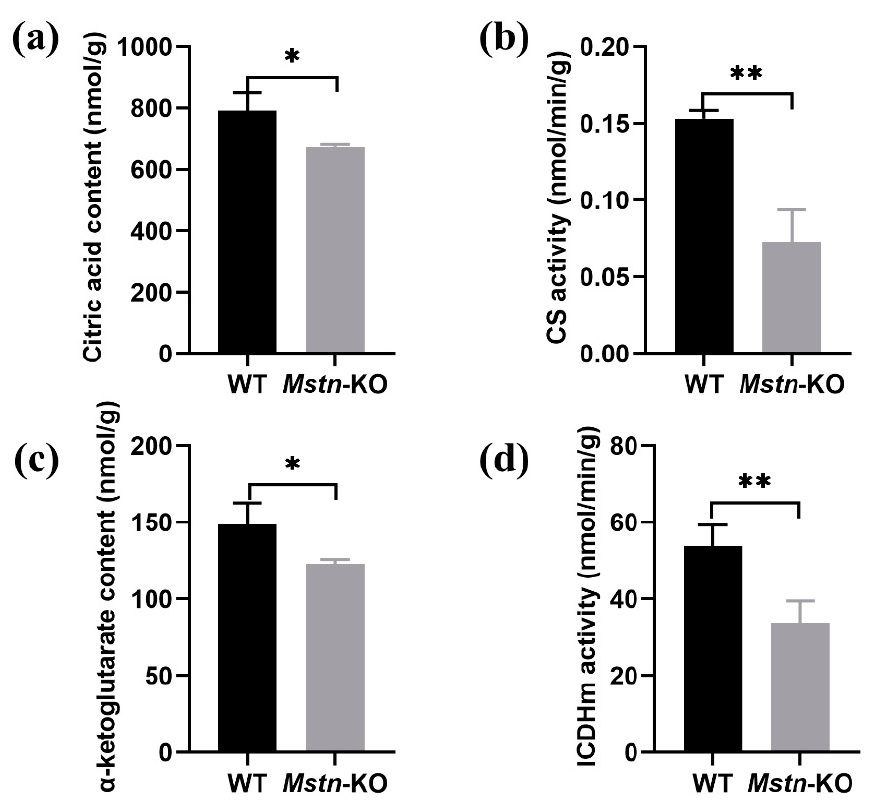
Figure 5. Key enzymes and metabolites in the tricarboxylic acid (TCA) cycle. ( a ) Citrate acid content of the initial step product in the TCA cycle ( n = 3). ( b ) Citrate synthase activity in Mstn -KO and WT mice ( n = 3). ( c ) α -ketoglutarate content in Mstn -KO and WT mice ( n = 3). ( d ) Isocitrate dehydrogenase activity in Mstn -KO and WT mice ( n = 3). All data are presented as mean ± SD. * p < 0.05, ** p < 0.01; t-tests were used to calculate the p -values.